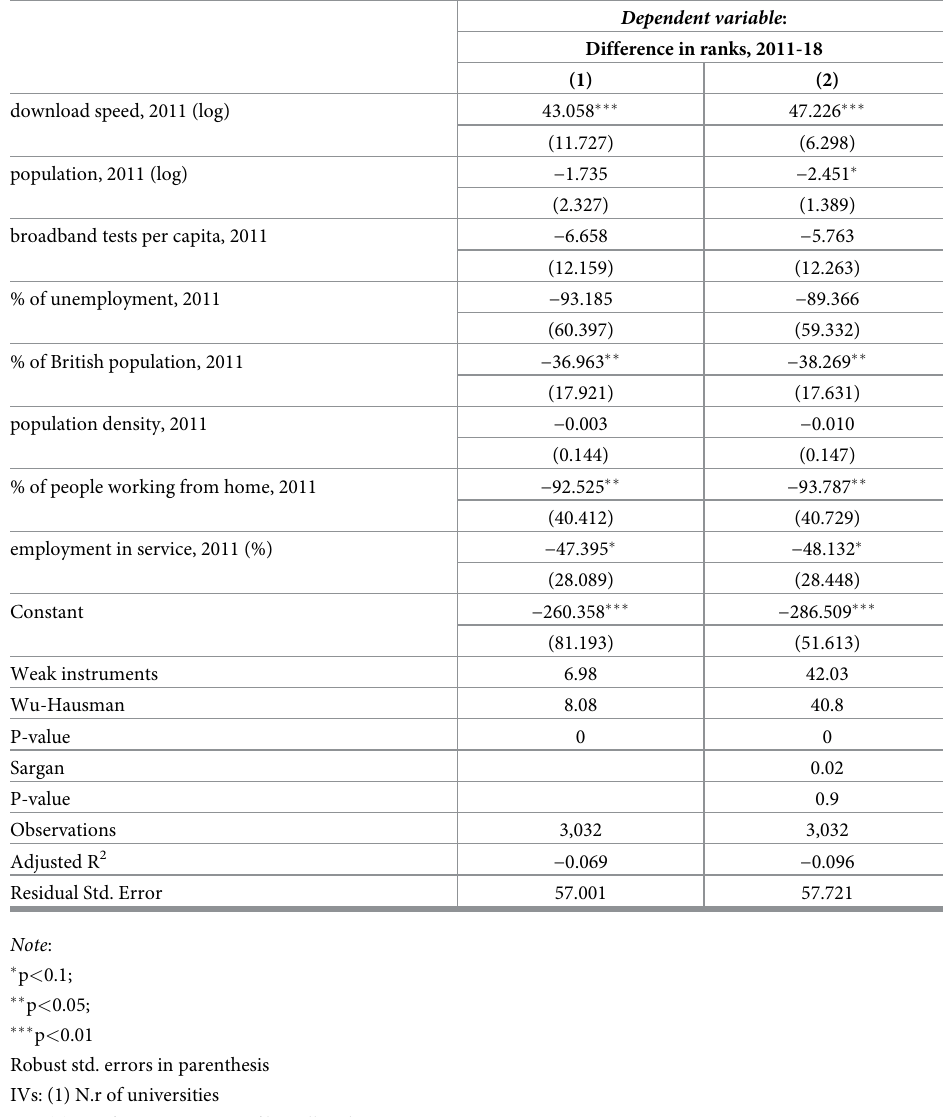
Table 11. 2SLS estimation of Eq (4) for the